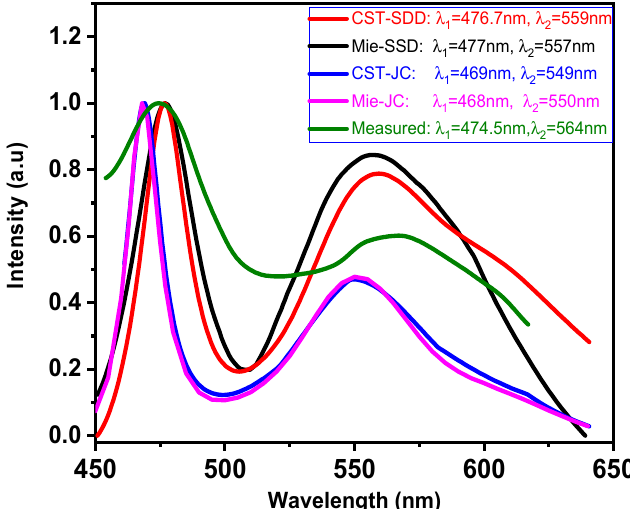
Figure 4. Comparison of the measured and simulated (CST and Mie theory) results for Sample S2.